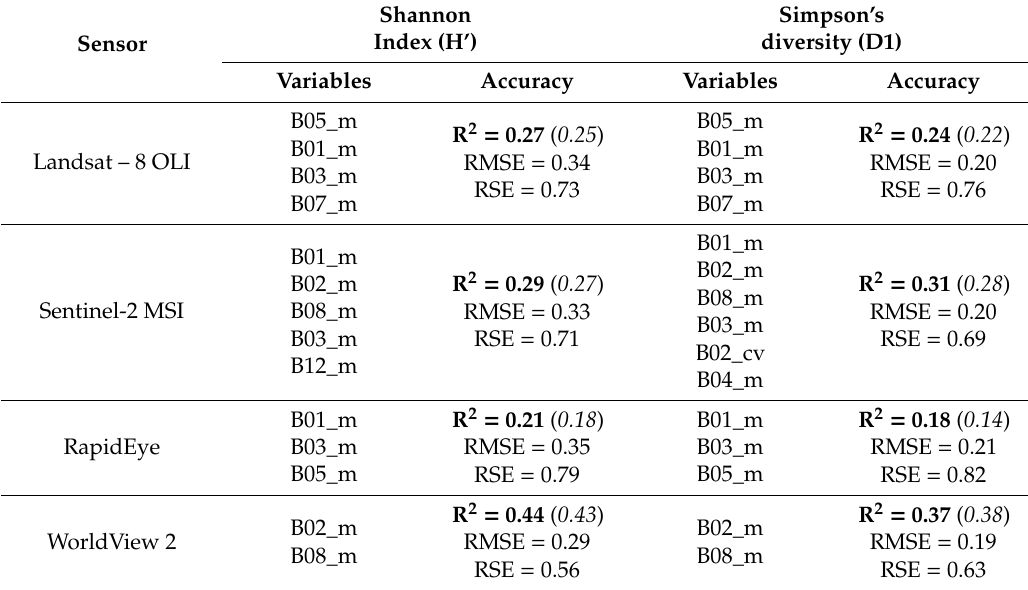
Table 3. Goodness-of-fit measures between predicted tree species diversity from Landsat 8 Operational Land Imager (OLI), Sentinel-2 Sentinel-2 Multispectral Instrument (MSI), RapidEye and WorldView 2 imagery and observed Shannon Index ( H’ ) and Simpson’s diversity ( D1 ), as well as variables included in the optimal models. The values in the parenthesis correspond to the accuracy ( R 2 ) obtained when the full variable set for an image was used in the random forest (RF)